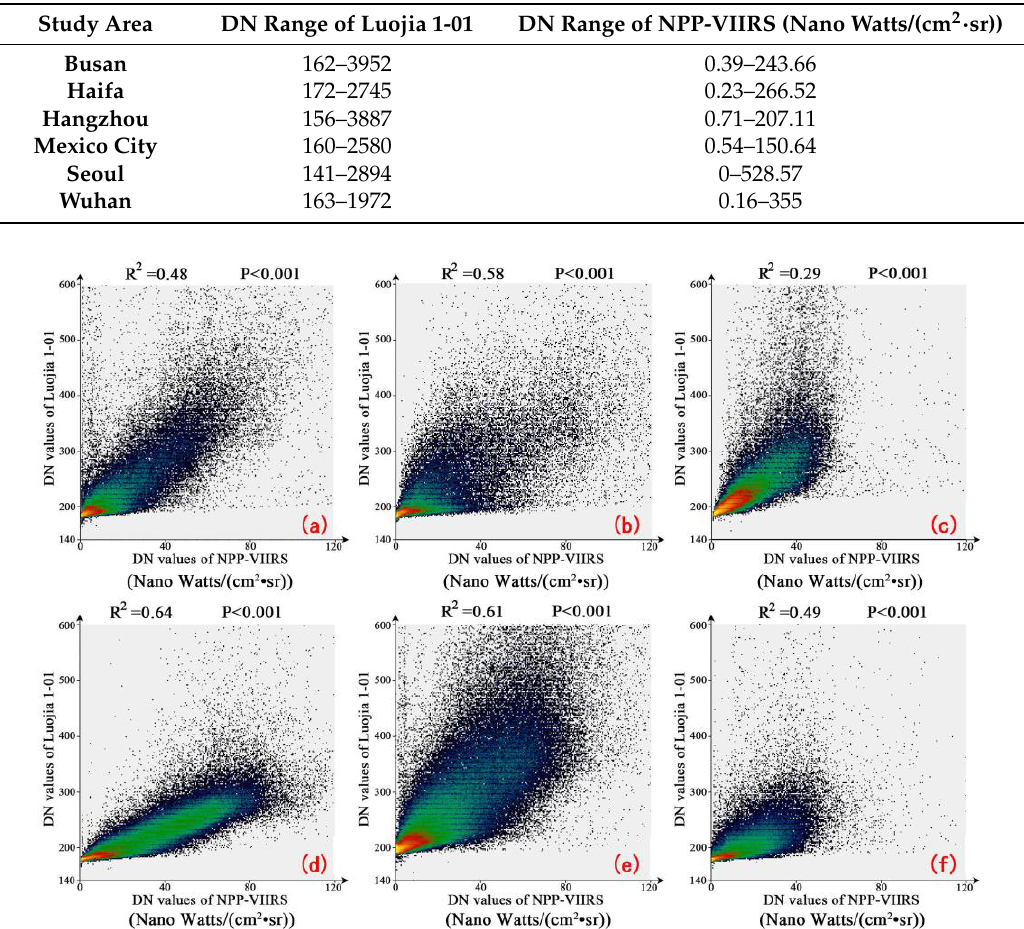
Figure 4. The scatter plot between Luojia 1-01 and Suomi National Polar-Orbiting Partnership Visible Infrared Imaging Radiometer Suite (NPP-VIIRS) for six cities: ( a ) refers to Busan; ( b ) refers to Haifa; ( c ) refers to Hangzhou; ( d ) refers to Mexico City; ( e ) refers to Seoul; ( f ) refers to